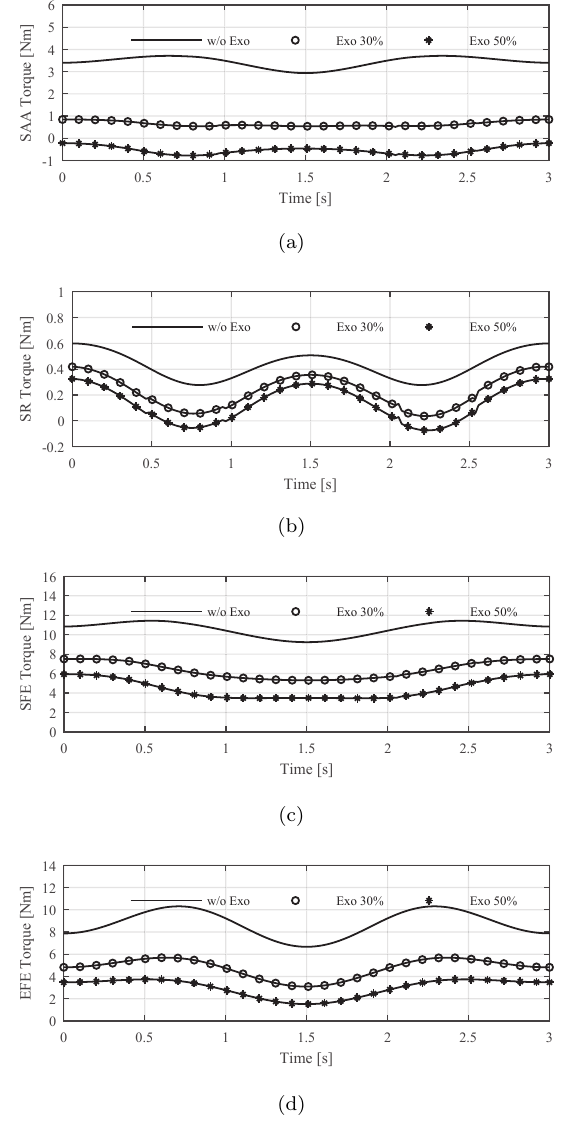
Figure 7: Equivalent joint torques in the human mus- culoskeletal system during the bicep curl; (a) shoulder abduction/adduction, (b) shoulder internal/external rotation, (c) shoulder flex- ion/extension, (d) elbow flexion/extension